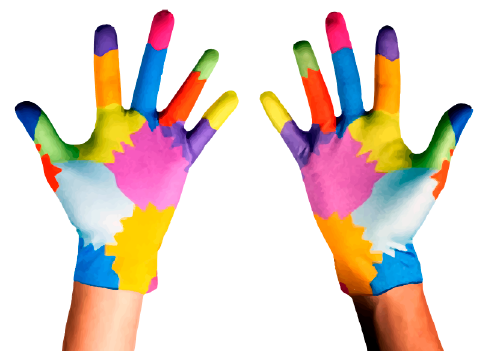
Figure 3. Passive gloves to help differentiate finger position.